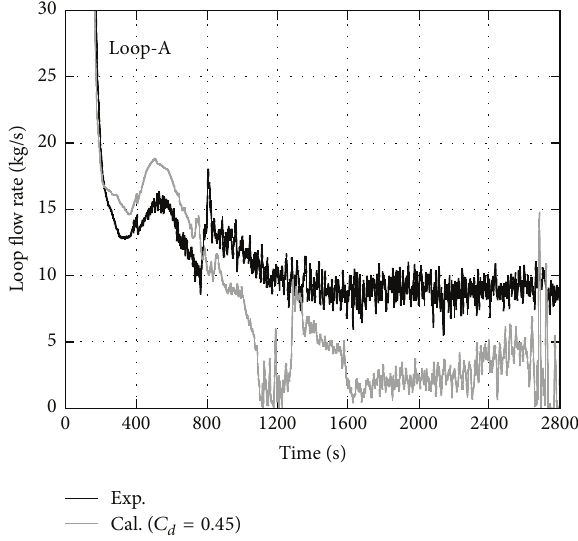
Figure 23: LSTF and RELAP5 results for primary loop flow rate in loop-A in case of no release of dissolved